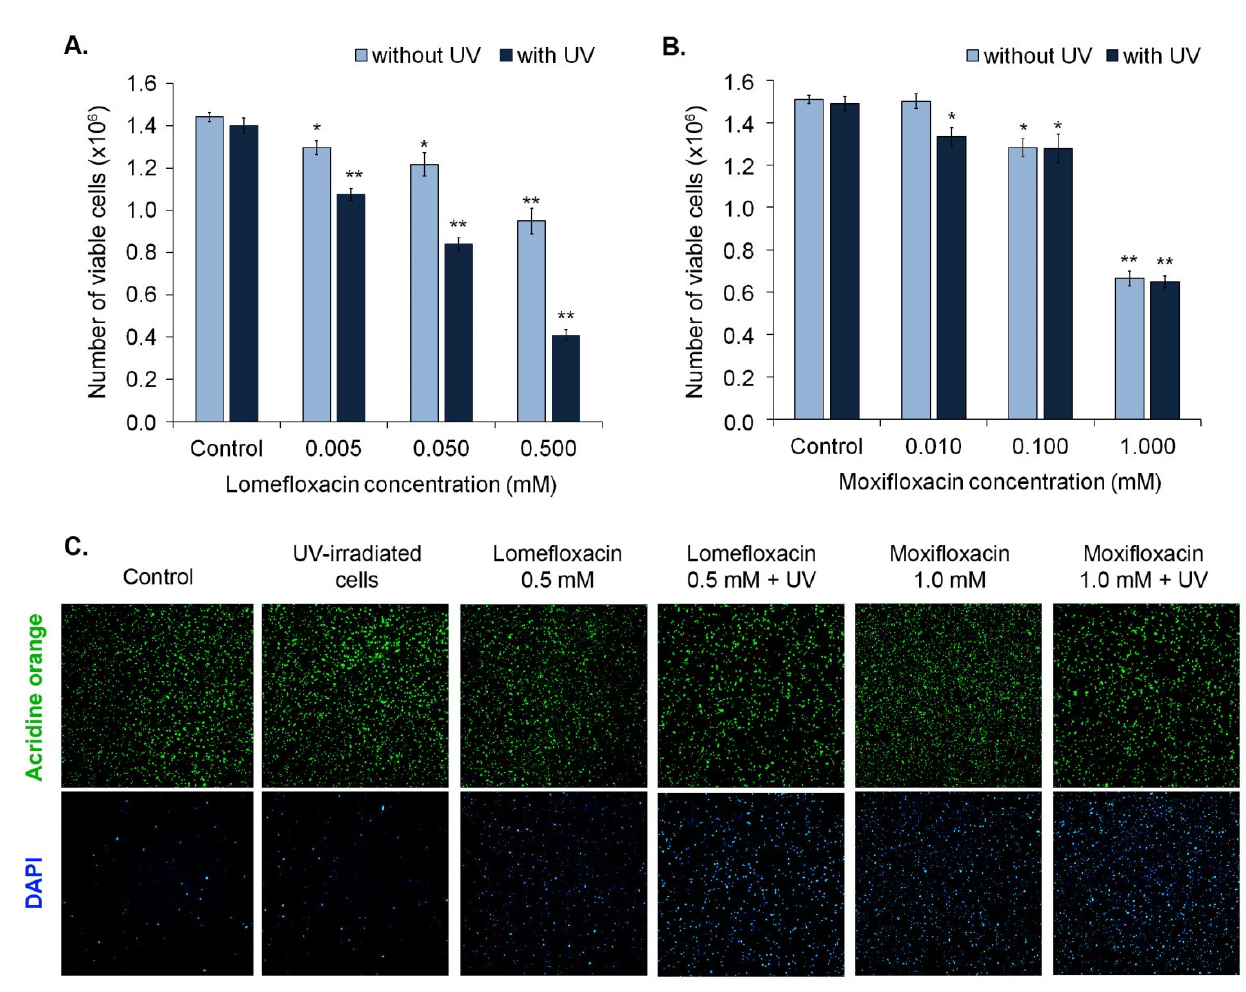
Figure 3. Impact of fluoroquinolones on melanocytes viability. The cells were exposed to lomefloxacin in concentrations of 0.005 mM, 0.05 mM, and 0.5 mM ( A ) and moxifloxacin in concentrations of 0.01 mM, 0.1 mM, and 1.0 mM ( B ). Cell number was determined after 24 h since the irradiation. Bar graph represents mean number of cells per dish ± SD from three independent experiments. * p < 0.05, ** p < 0.01 vs control. ( C ). Representative images were obtained using NucleoCounter NC-3000 fluorescence image cytometer. Acridine orange stained all cells in the sample and DAPI stained the dead cells.